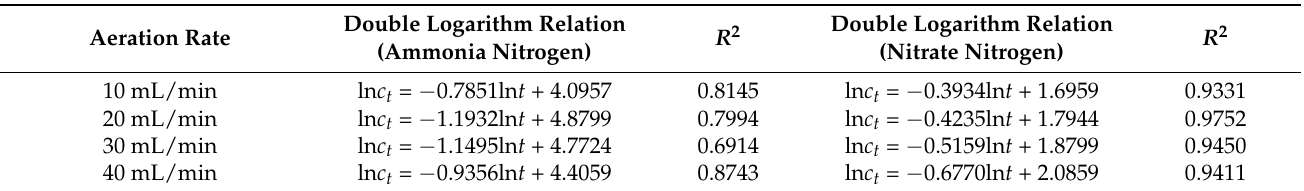
Figure 8. Double logarithm regression relationship between ammonia nitrogen/nitrate nitrogen concentration in overlying water and test days under aeration. Table 5. Double logarithm linear expression between ammonia nitrogen/nitrate nitrogen concentra- tion in overlying water and test days under aeration.